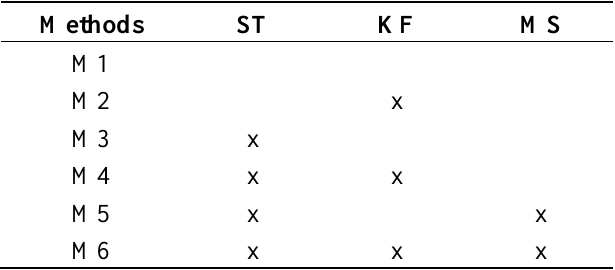
Table 2. Evaluated models where the used methods are indicated. Not all the combinations have been used because some of them were nonsensical.